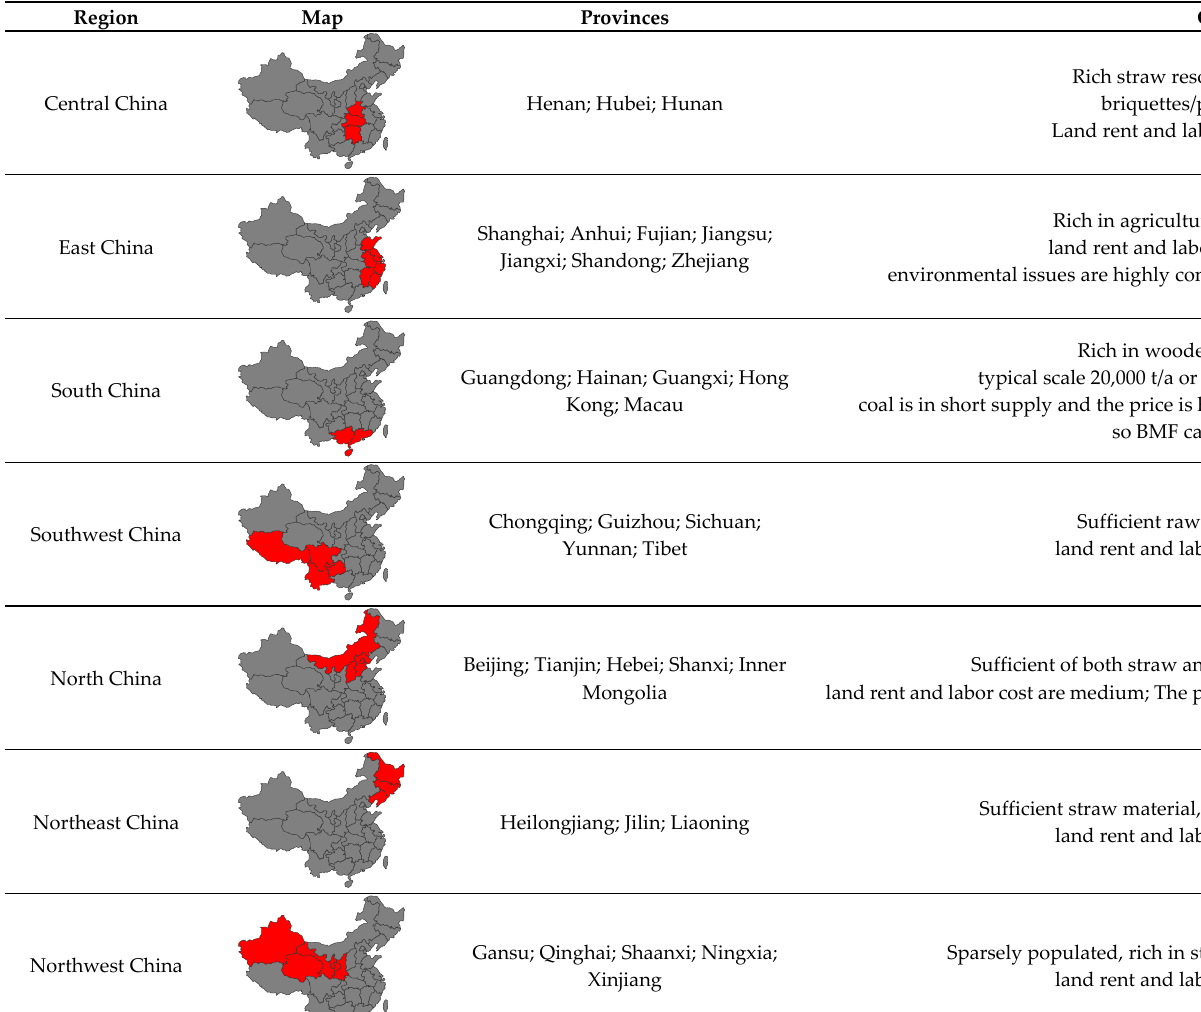
Table 2. The seven regions and its